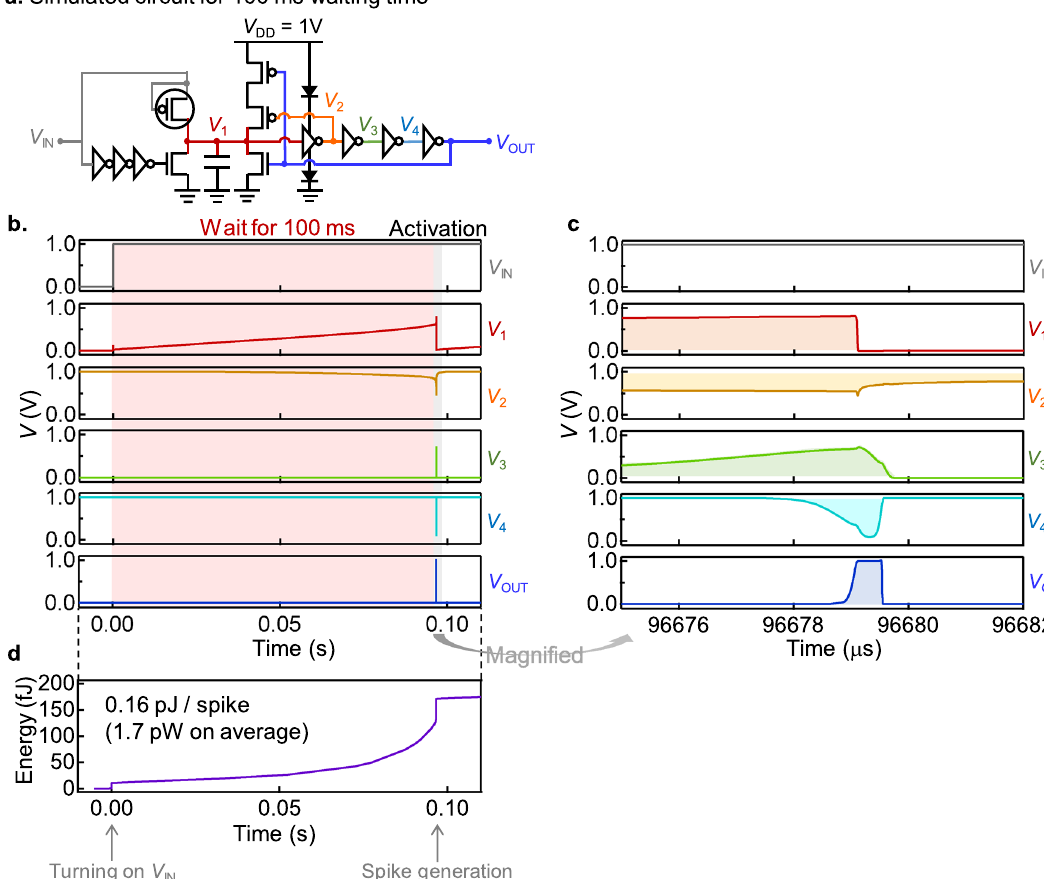
Figure 4. Simulation of the spiking neuron circuit. ( a ) The simulated spiking neuron circuit for the 100 ms waiting time. ( b ) The voltage wave forms at several different nodes in ( a ). The red shadowed region indicates the waiting time of this neuron circuit. ( c ) The magnification of ( b ) in the vicinity of the spike generation event, which is indicated by the grey shadow. ( d ) The simulated energy consumption of the spiking neuron circuit, which rapidly increases as approaching the spiking event due to the increase in the through current at the first-stage inverter. The detailed operation of the 1 μs spiking neuron circuit is also presented in Supplementary Note 4, and the simulations of all the spiking neuron circuits with different waiting times are presented in Supplementary Note